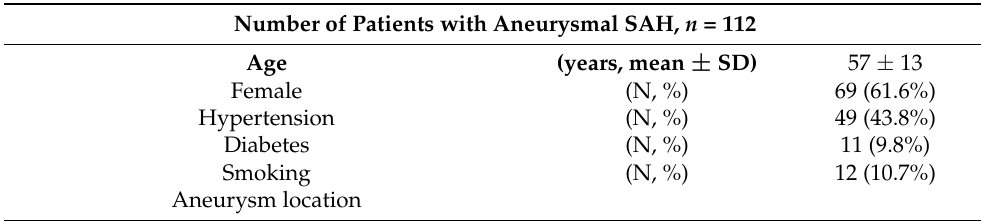
Table 1. Patients characteristics. SAH, subarachnoid hemorrhage. Number of Patients with Aneurysmal SAH, n =